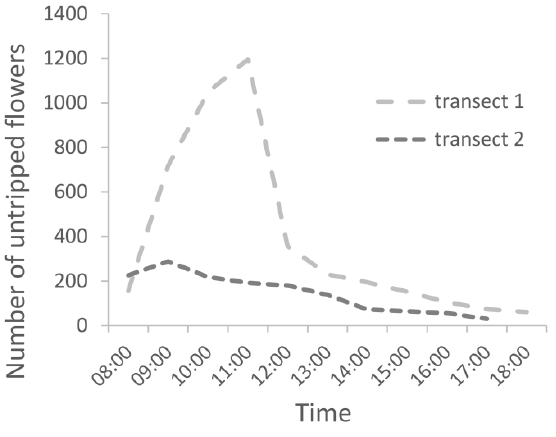
F IGURE 3. The number of untripped D. setigerum flowers available across the day in two transects. Numbers of flowers increase initially as flowers open in the morning, but steadily decrease during the day as nearly all flowers become tripped by 1800